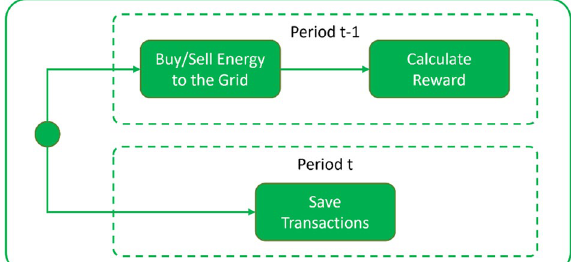
Fig. 4 RL after market